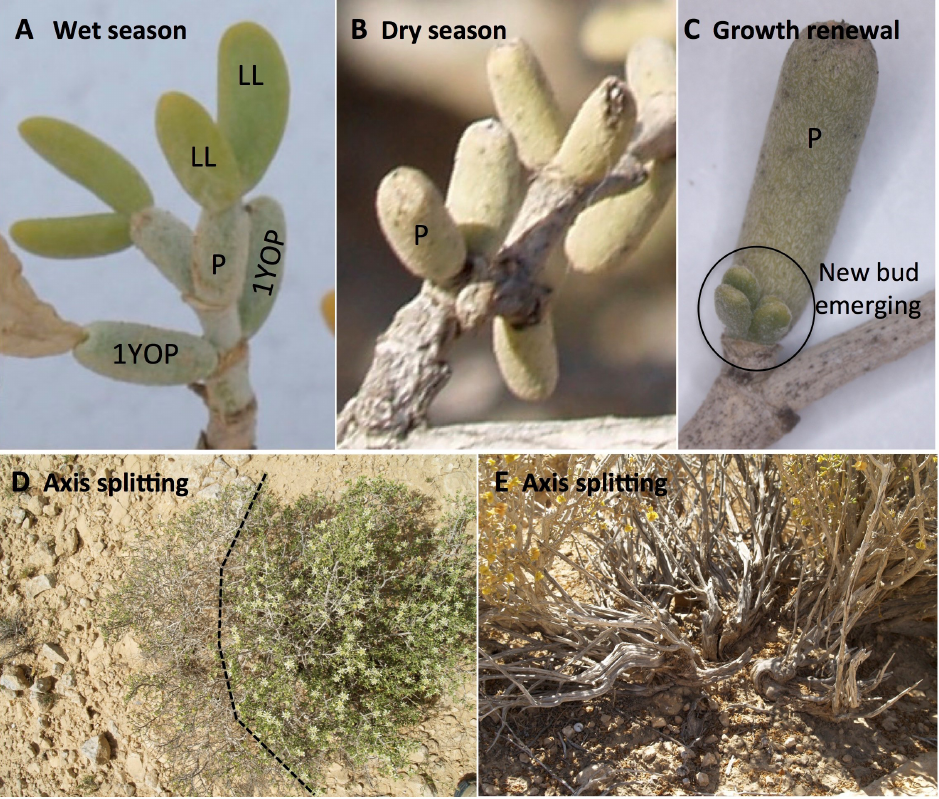
Figure 1. Phenology of Zygophyllum dumosum Boiss growing on a southeast-facing slope at Sede Boqer research area (30o 51 (cid:48) N 34o 46 (cid:48) E; elevation 498 m). ( A ) A typical branch of Zygophyllum plant during the wet season (March 2008). Note the coumpond leaf composed of two leaflets (LL) carried on a fleshy, cylindrical petiole (P). 1YOP, 1-year-old petiole. ( B ) A typical Z. dumosum branch during the dry season carrying petioles (P). ( C ) A closer look at emerging new bud from the axil of a 1YOP at the beginning of the winter. ( D ) Axis splitting resulting in a dual appearance of a Z. dumosum plant showing healthy branches carrying new leaves and flowers (right from the broken line) and unhealthy branches (left from the broken line). ( E ) A Z. dumosum plant with the main axis divided into several distinct